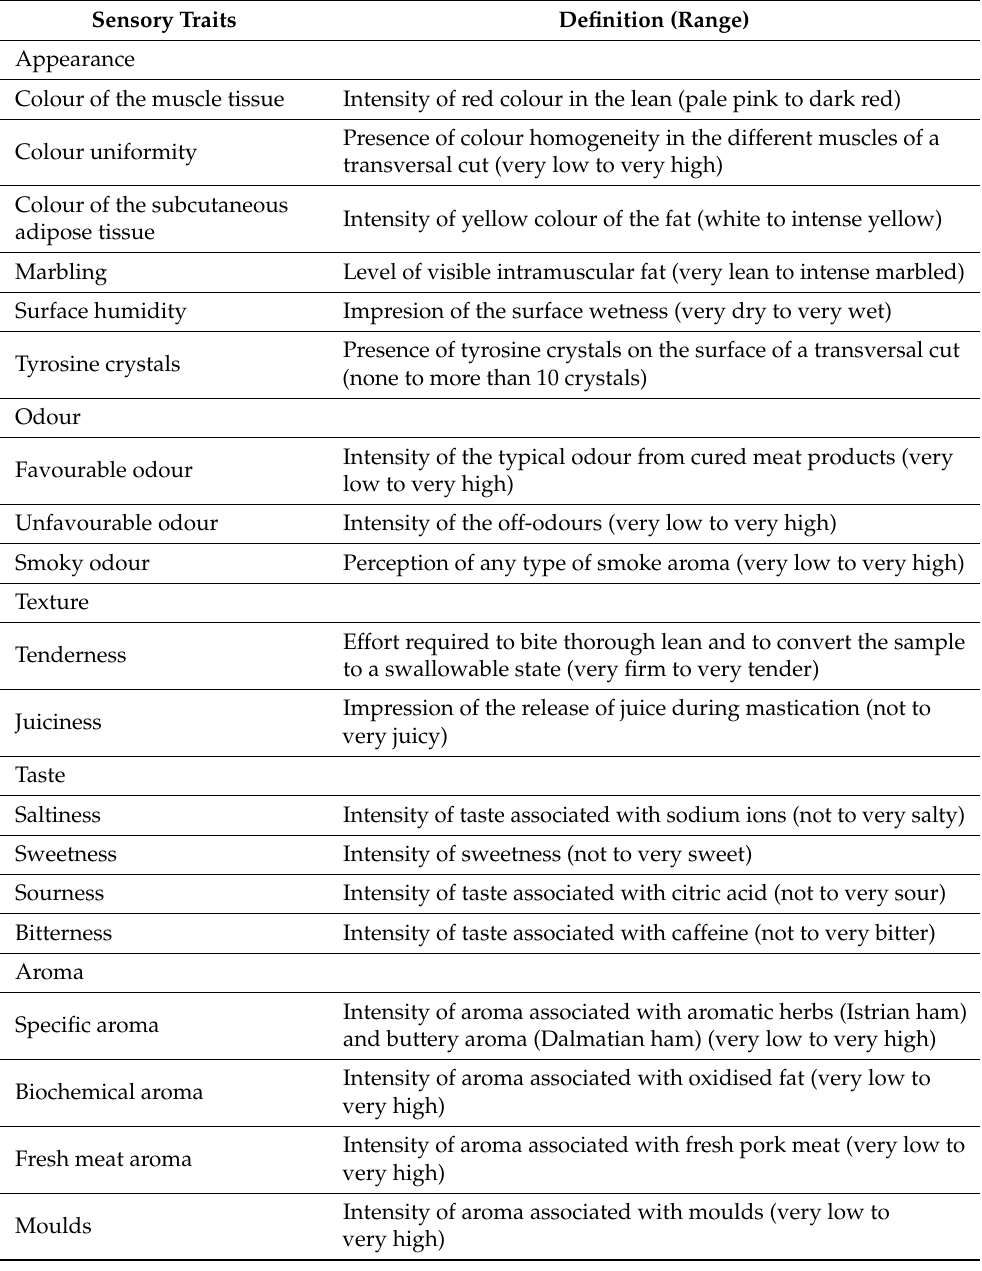
Table 1. Sensory traits, definitions and range implemented for sensory evaluation of dry-cured ham